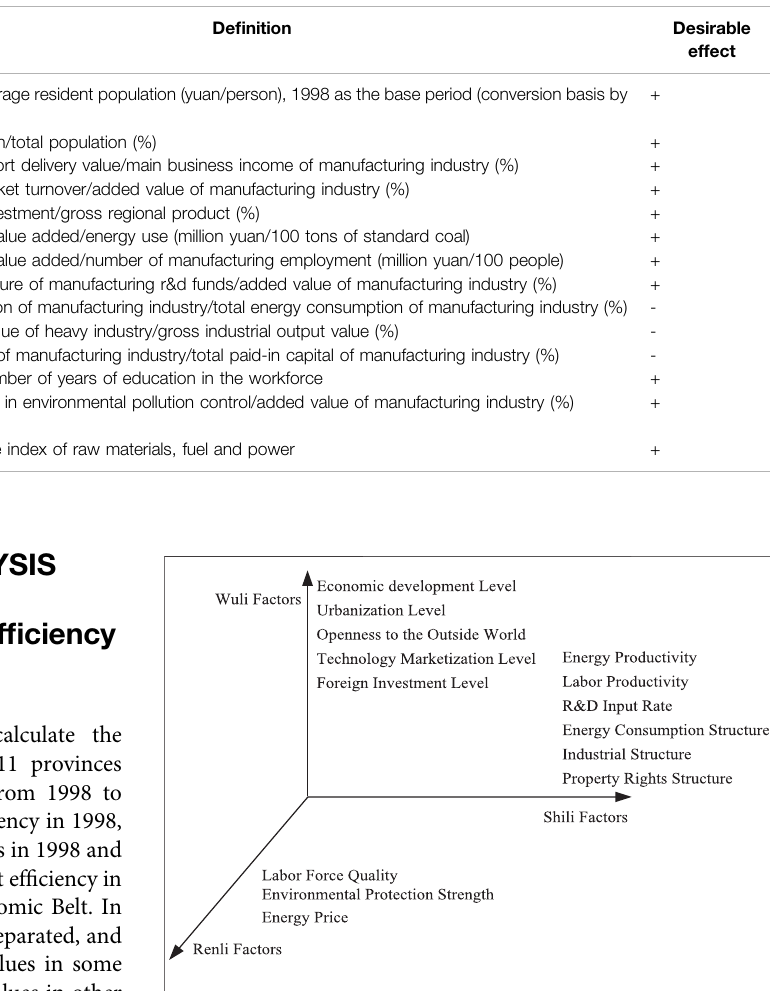
TABLE 1 | Description of in fl uencing factor variables.